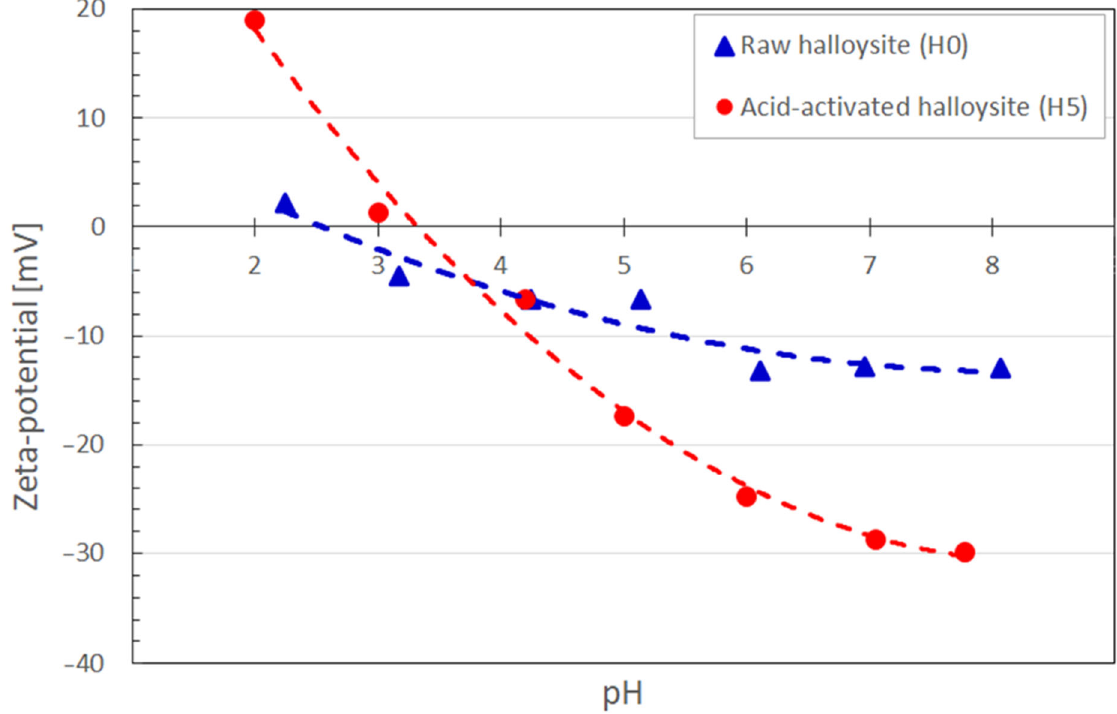
Figure 3. The influence of pH value on zeta potential for raw (H0) and acid ‐ activated (H5) halloysite.